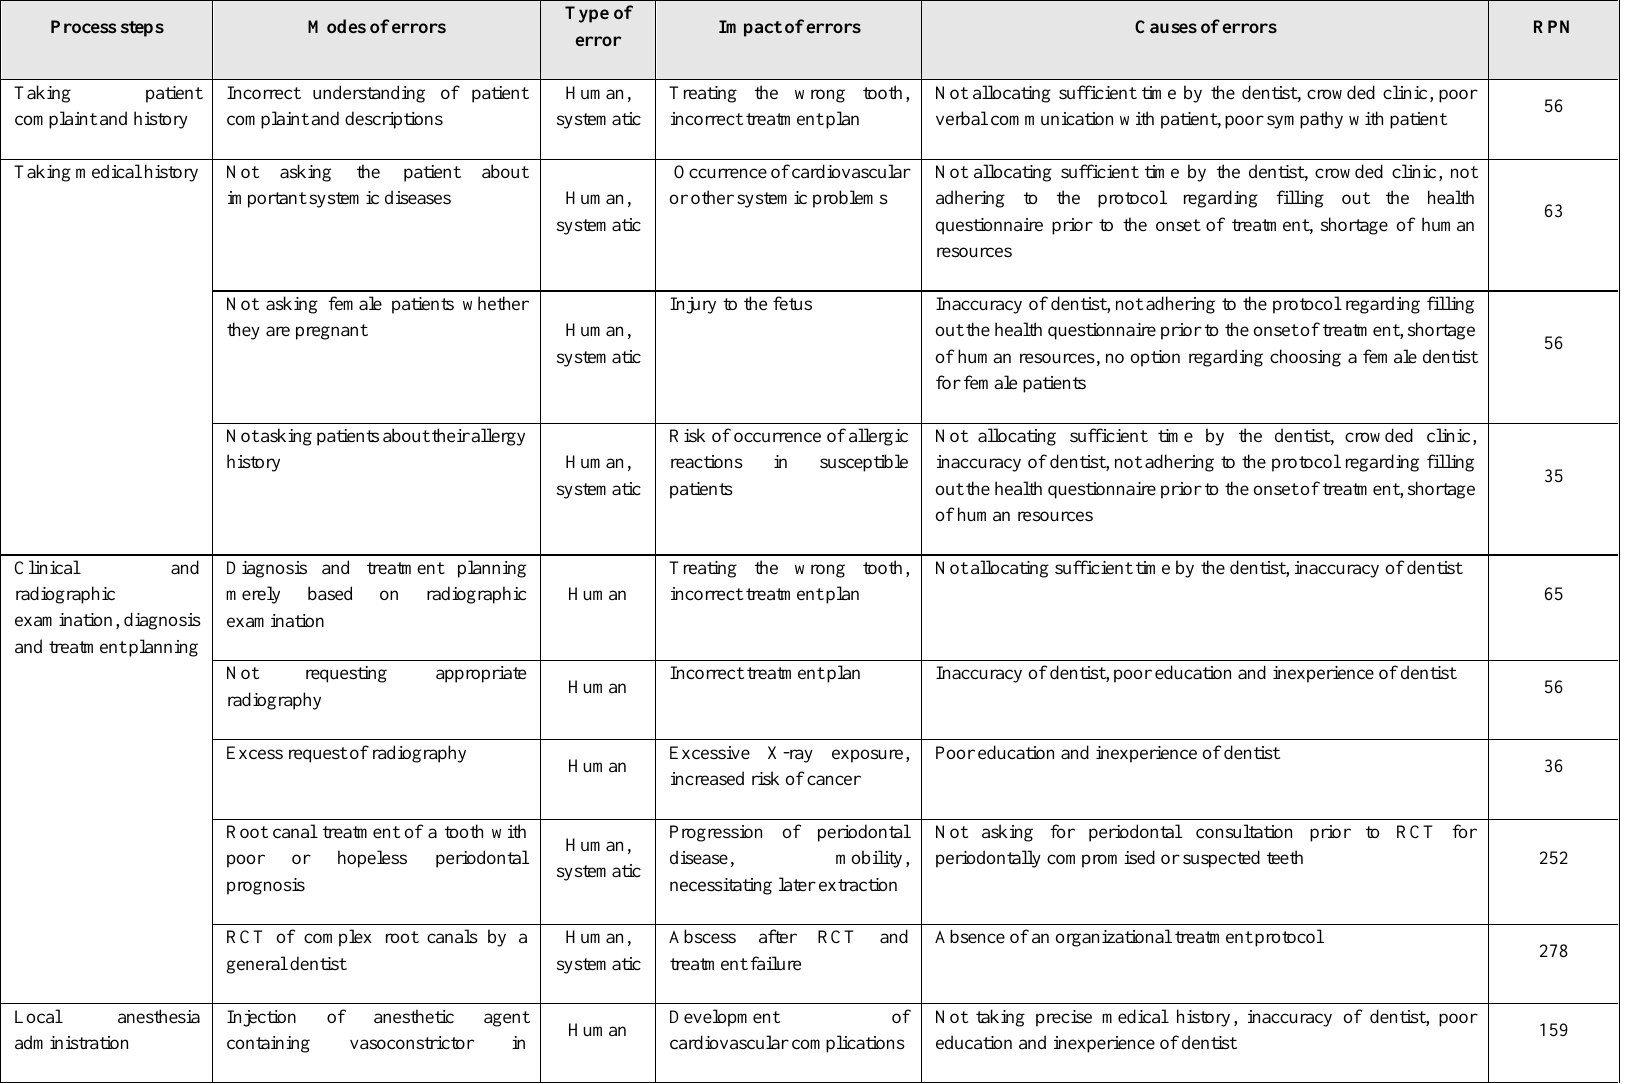
Table 2. Primary FMEA worksheet for